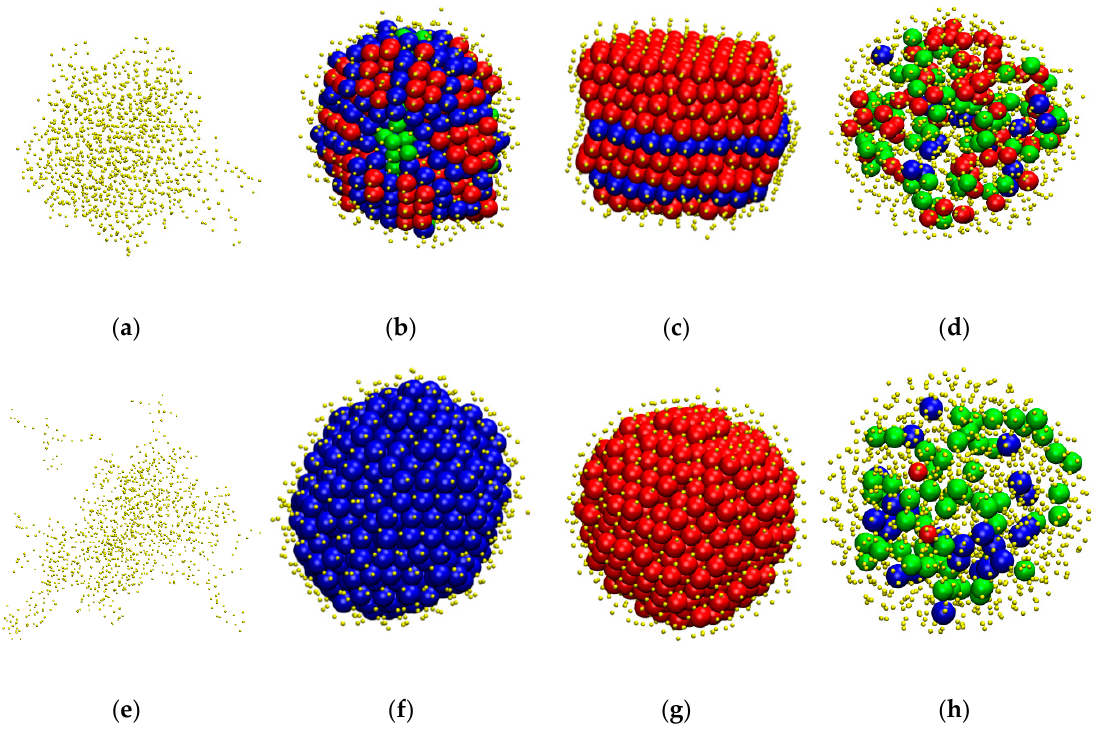
Figure 7. Snapshots of system configurations at the end of the MC simulation corresponding to the following sets of interaction intensity, ε , and range, σ 2 . Top row: fixed range σ 2 = 1.2 and ( a ) ε = 0.6; ( b ) ε = 1.0; ( c ) ε = 1.2; ( d ): ε = 2.0. Bottom row: fixed intensity ε = 0.5 and ( e ) σ 2 = 1.2; ( f ) σ 2 = 2.0; ( g ) σ 2 = 2.5; ( h ) σ 2 = 3.0. Sphere monomers are color-coded according to the CCE norm: Blue, red and green